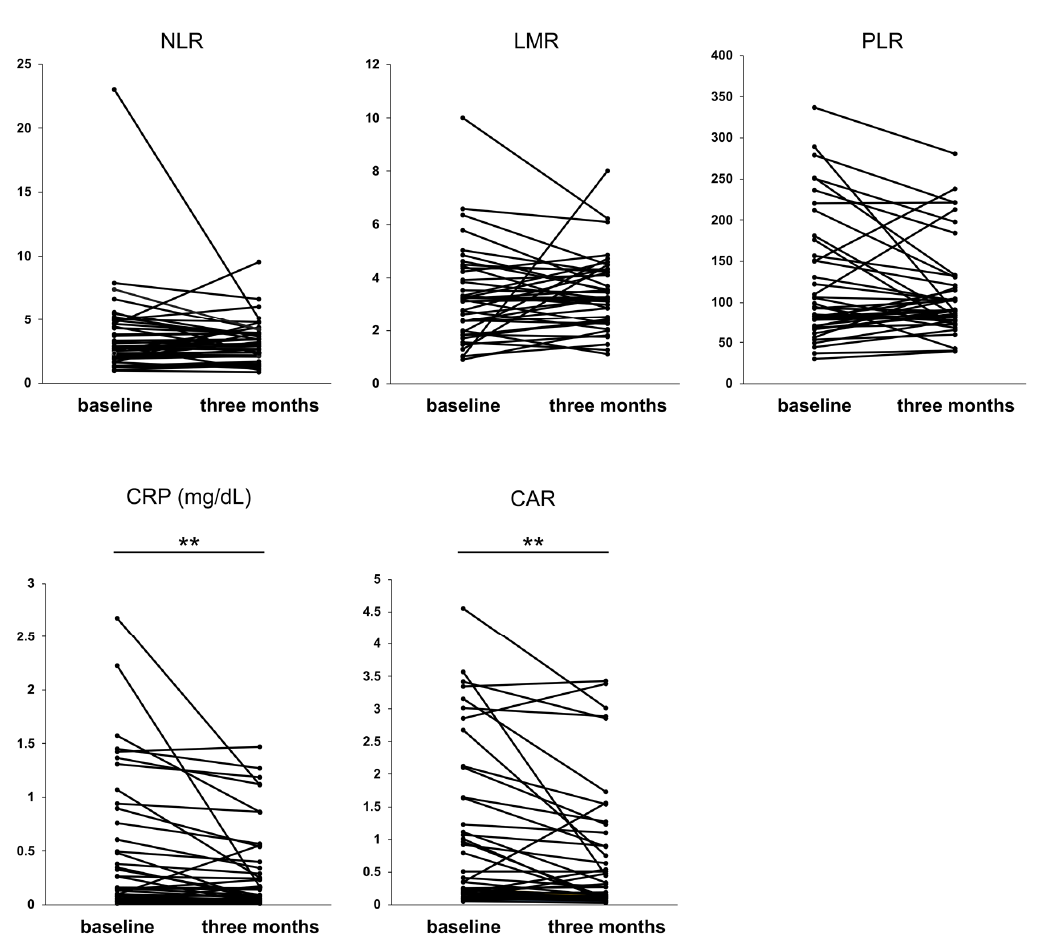
Figure 3. Values of the inflammation-based markers at three months of rifaximin administration. ** p < 0.01. NLR, neutrophil–lymphocyte ratio; LMR, lymphocyte–monocyte ratio; PLR, platelet–lymphocyte ratio; CRP, C-reactive protein; CAR, CRP to albumin protein.